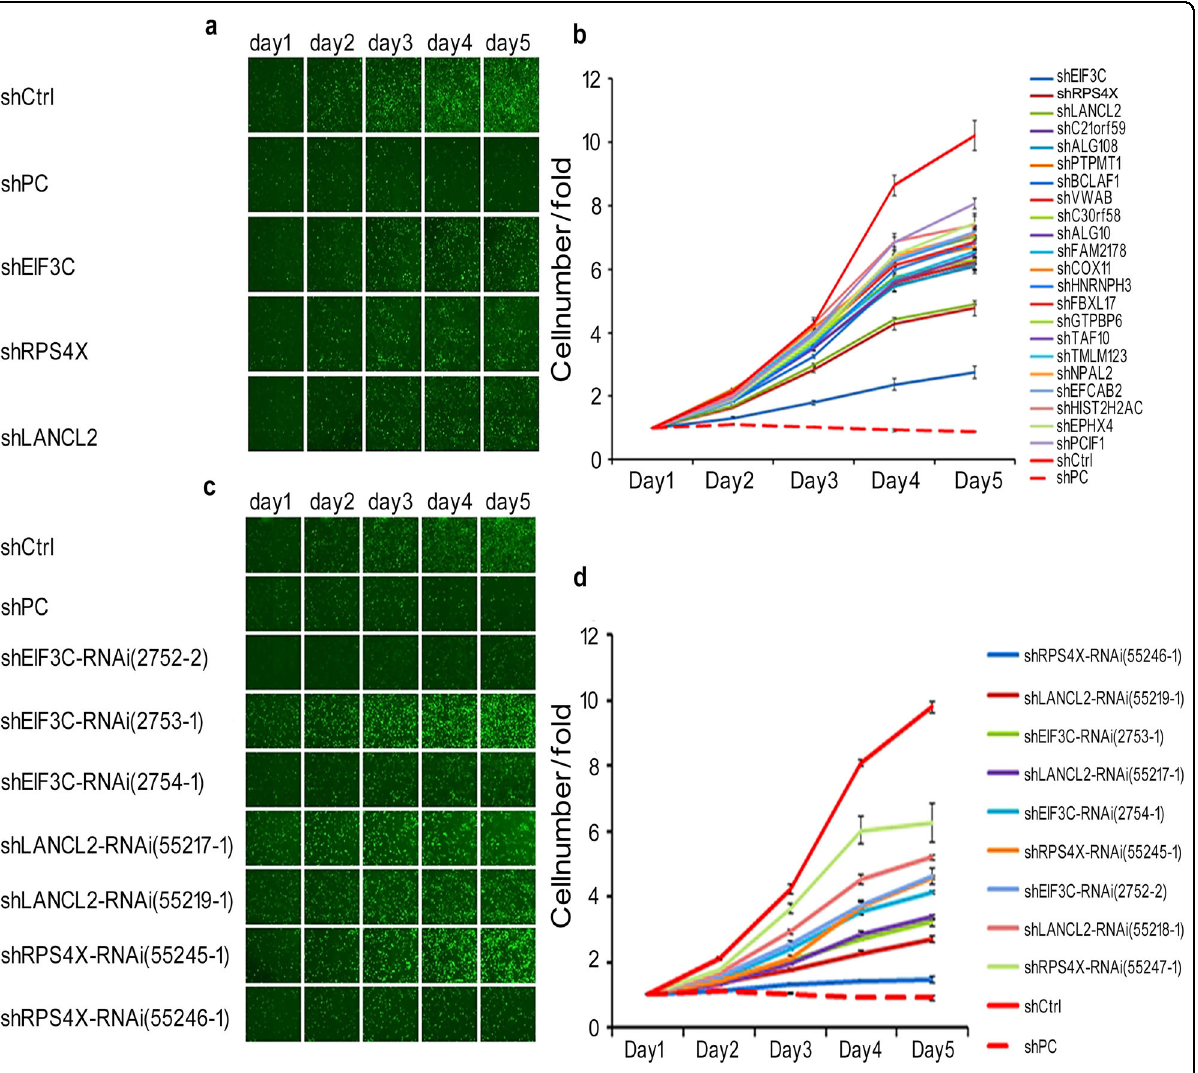
Fig. 1 Identi fi cation of LANCL2 in PC9 cells using high content screening (HCS). a In the initial HCS on day 0, the candidate genes were individually silenced in PC9 cells using lentiviral shRNA-mediated knockdown. From day 1-4, HCS cell count analyses were conducted using the Cellomics ArrayScan. b Quanti fi cation of fold-changes in cell counts used as a measure of cell proliferation. c The shRNAs negating RPS4X, EIF3C, and LANCL2 expression were selected for individual veri fi cation in a secondary HCS. d Quanti fi cation of fold-changes in cell counts used as a measure of cell proliferation. Data presented as means ± SDs. All in vitro experiments: three biological replicates × three technical